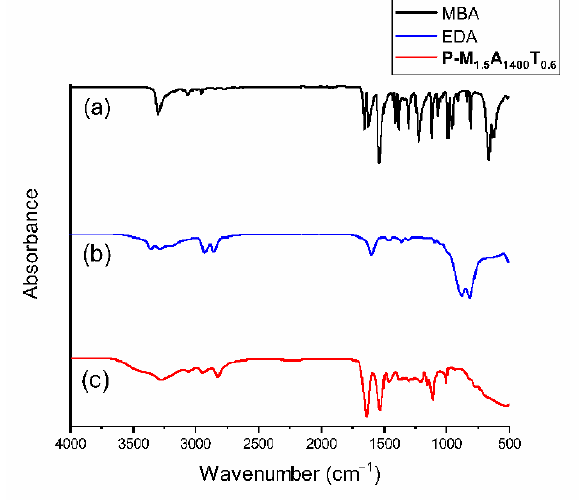
Figure 1. ATR-FTIR spectra of methylenebiscrylamide ( a ), ethylenediamine ( b ), and poly(amidoamine) particles ( P-M 1 . 5 A 1400 T 0 . 6 ) ( c ).